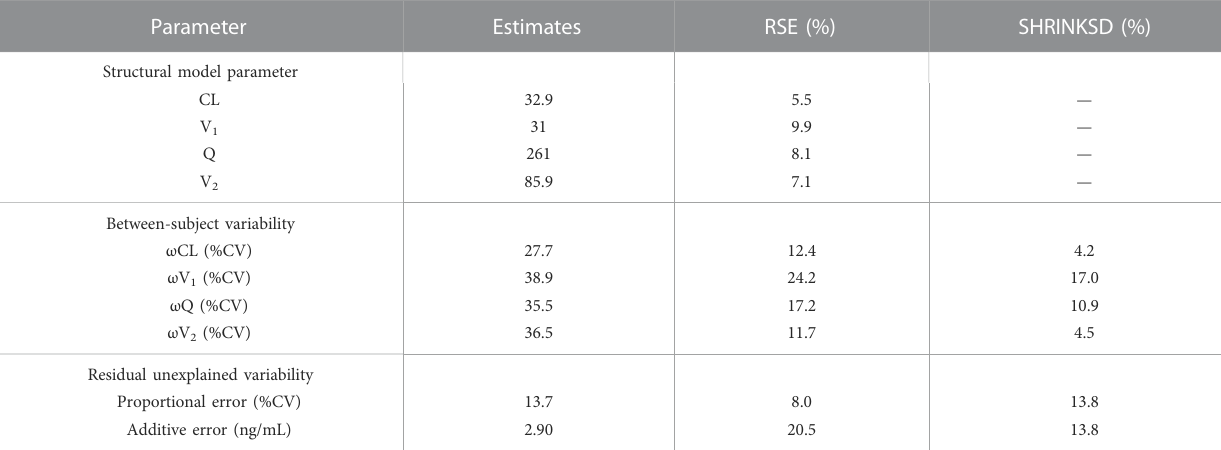
TABLE 2 Population pharmacokinetic parameter estimates of nalbuphine of the basic model.